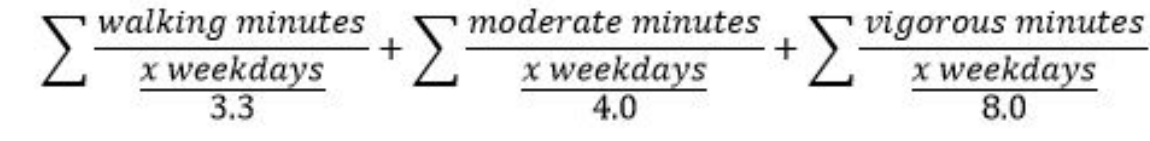
Figure 1. Equation used to calculate average weekday scores from the SenseWear Armband activity